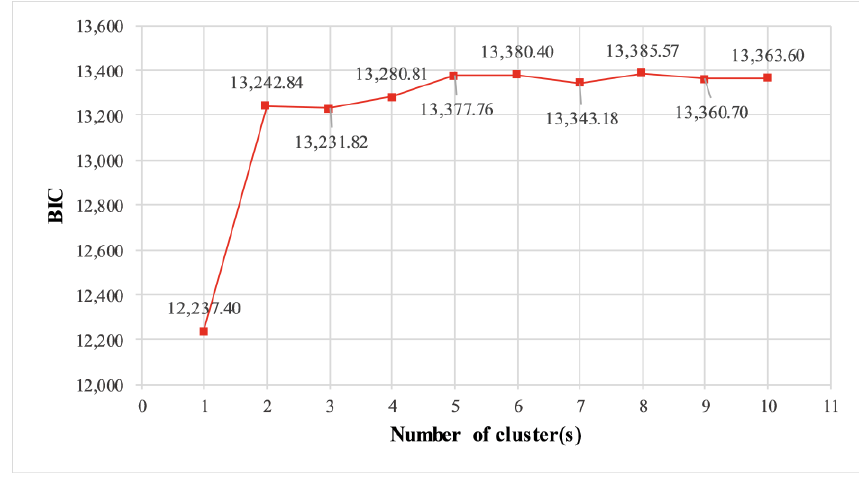
Figure 7. Variation of BIC value with the number of clusters.